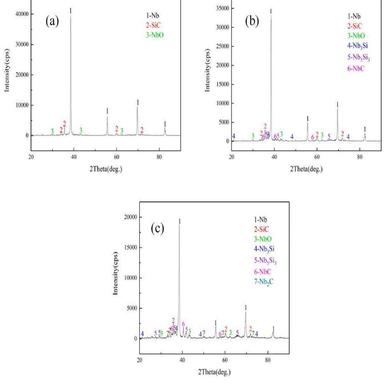
XRD patterns of Nb–SiC composite powder after constant temperature heating at different temperatures: (a) 900 ◦C, (b) 1100 ◦C, (c) 1200 ◦C.